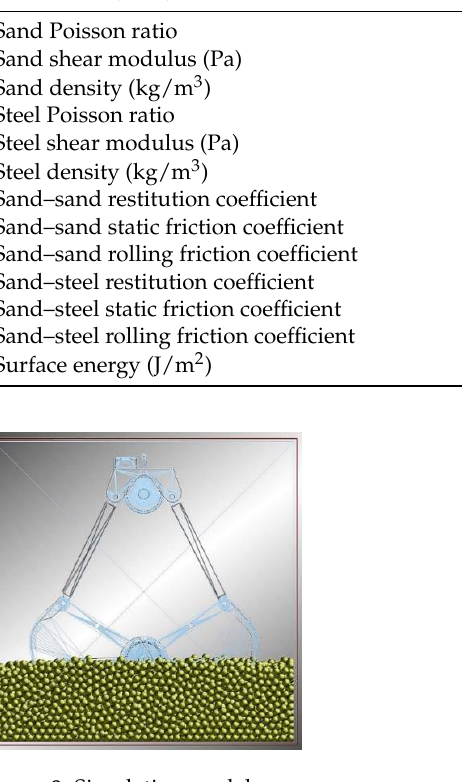
Figure 8. Simulation model.